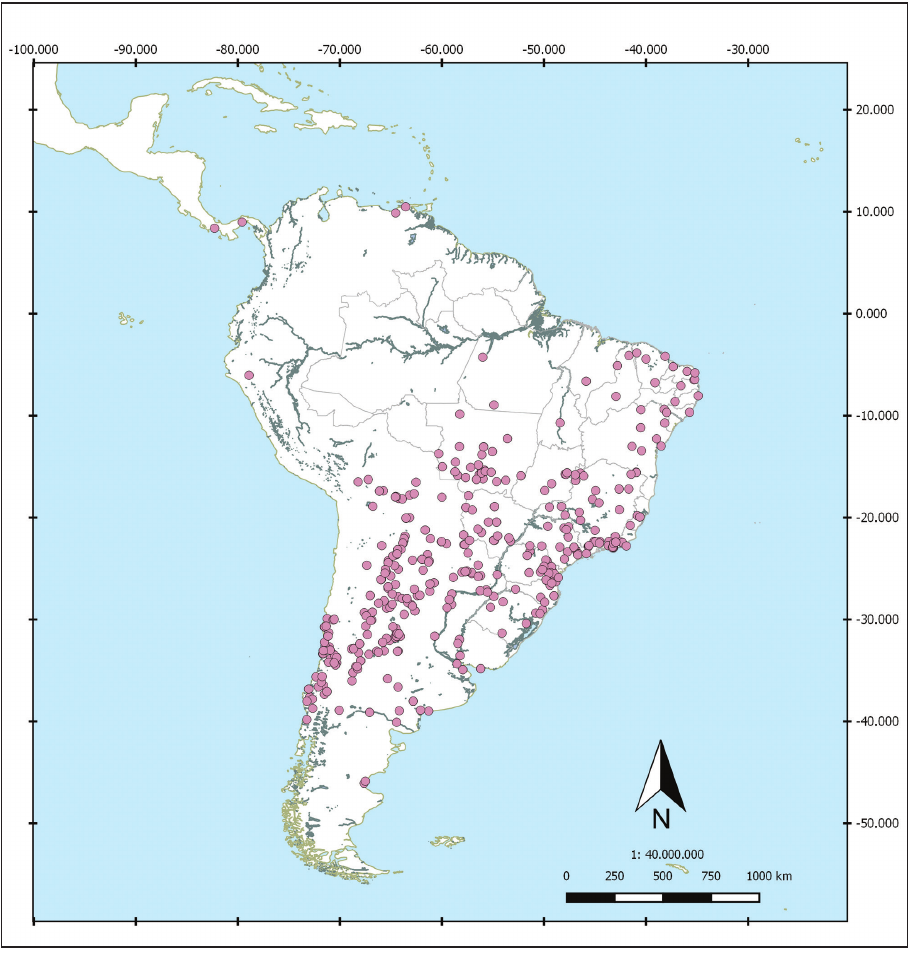
Figure 88. Geographical distribution of Liogenys Guérin-Méneville.